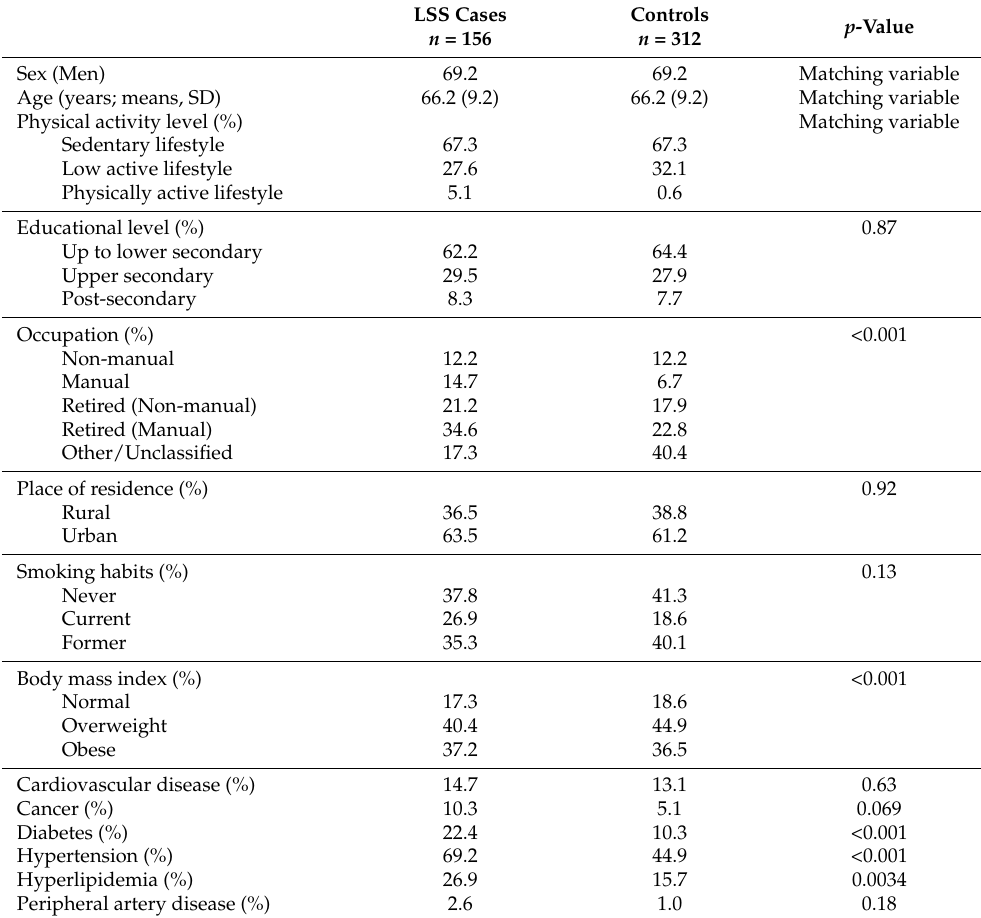
Table 1. Main characteristics of Lumbar Spinal Stenosis (LSS) cases and matched controls analyzed in the PREFACE